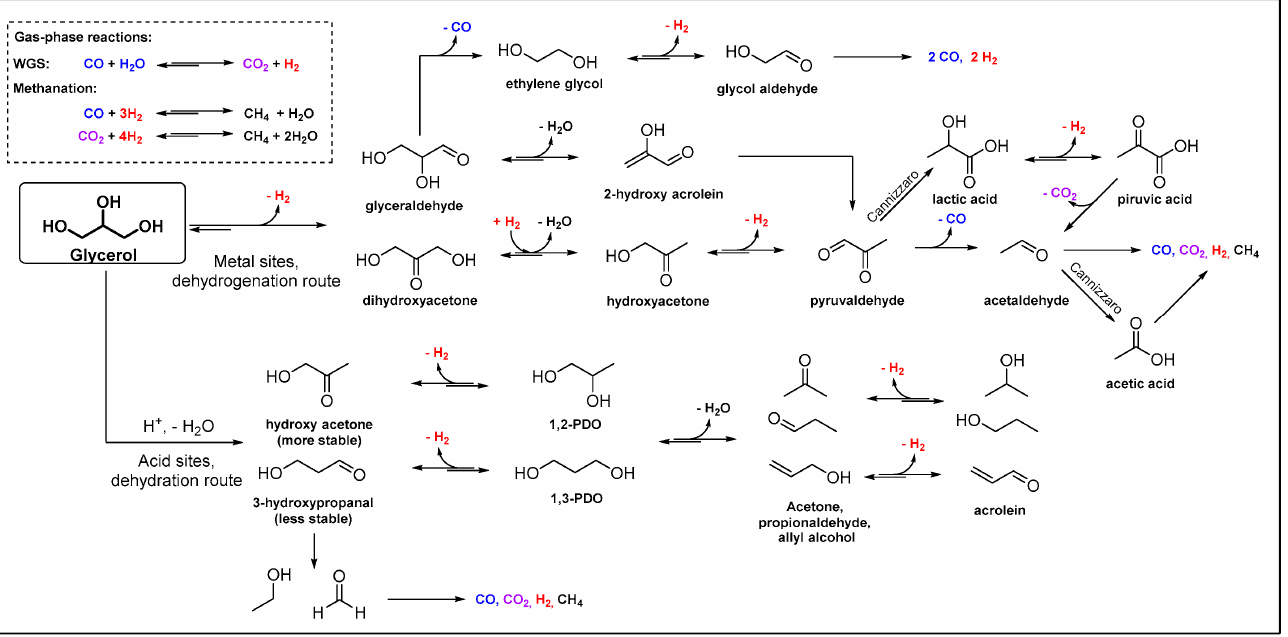
Figure 3. Reaction pathway for aqueous phase reforming of glycerol. Reprinted/adapted with permission from Fasolini, et al. [88], MDPI, 2019.